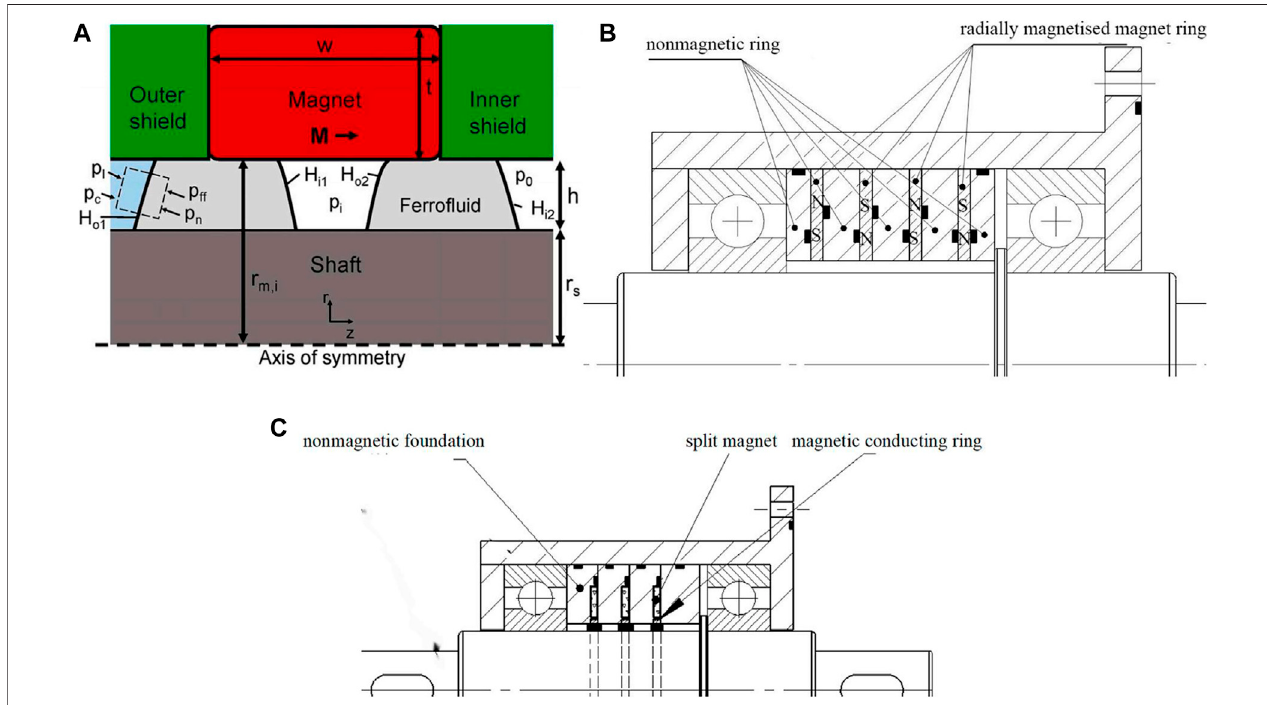
FIGURE1| Structure oftheFFseal. (A) FFsealproposedbyKaroen vander Waletc(vander Waletal.,2020); (B) FFradial-chargedseal; (C) FFsplitmagnetseal.